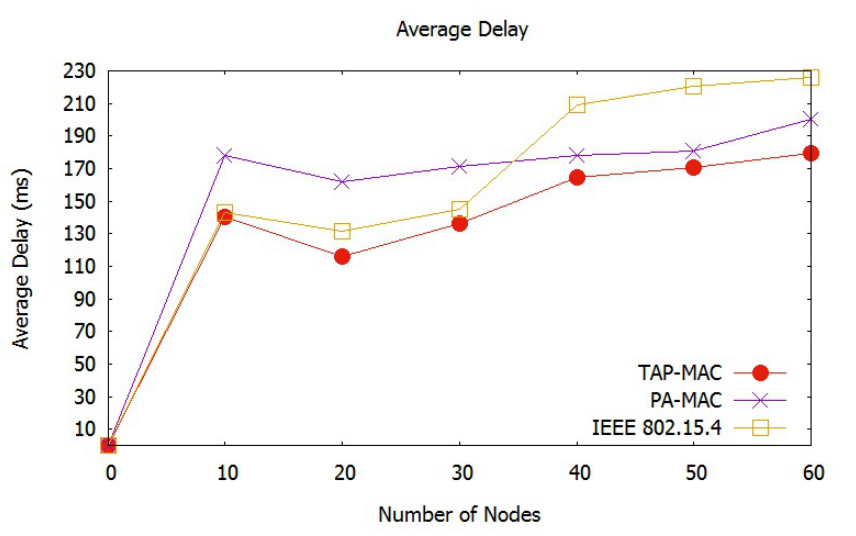
Figure 15. Scenario 3: Average network